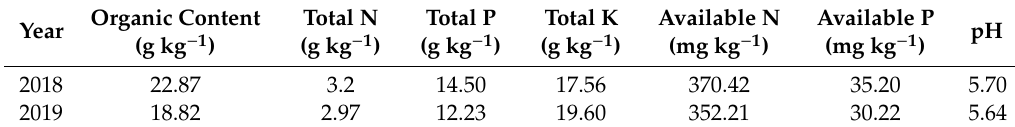
Table 1. Physical and chemical properties of the experiment soil.